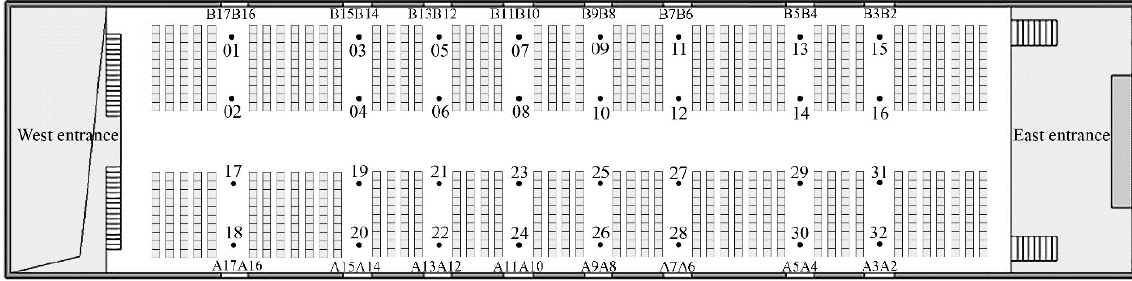
Figure 4. Solar radiation analysis diagram.